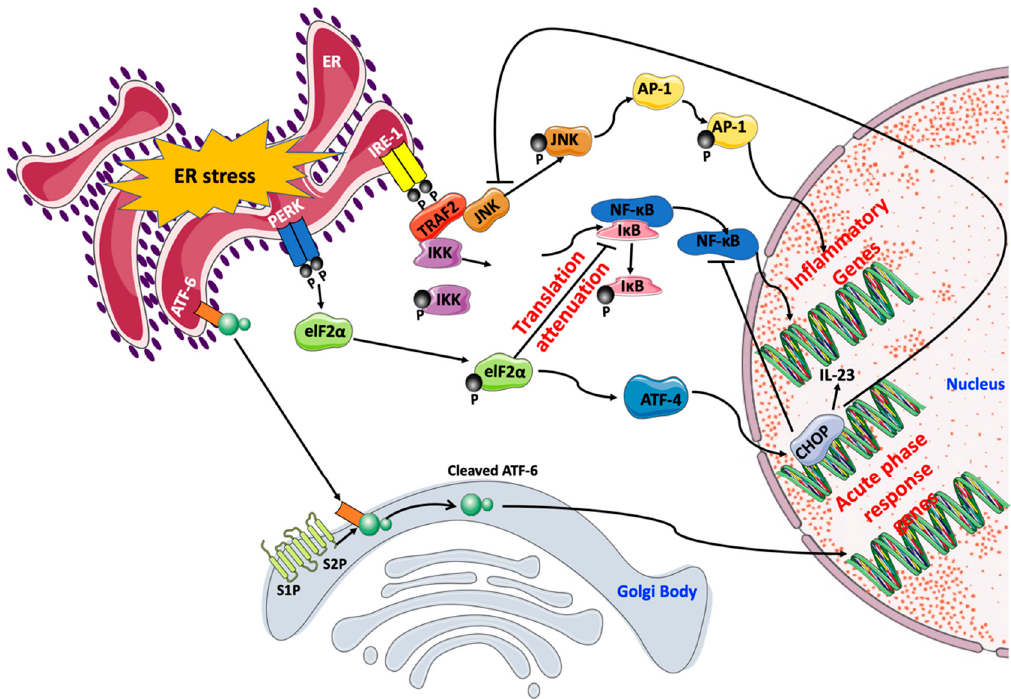
Figure 3. Activation of NF- κ B by PERK and ATF-6. The activation of the PERK/eIF-2 α axis leads to a severe reduction in protein translation, which decreases the expression levels of I κ B protein.